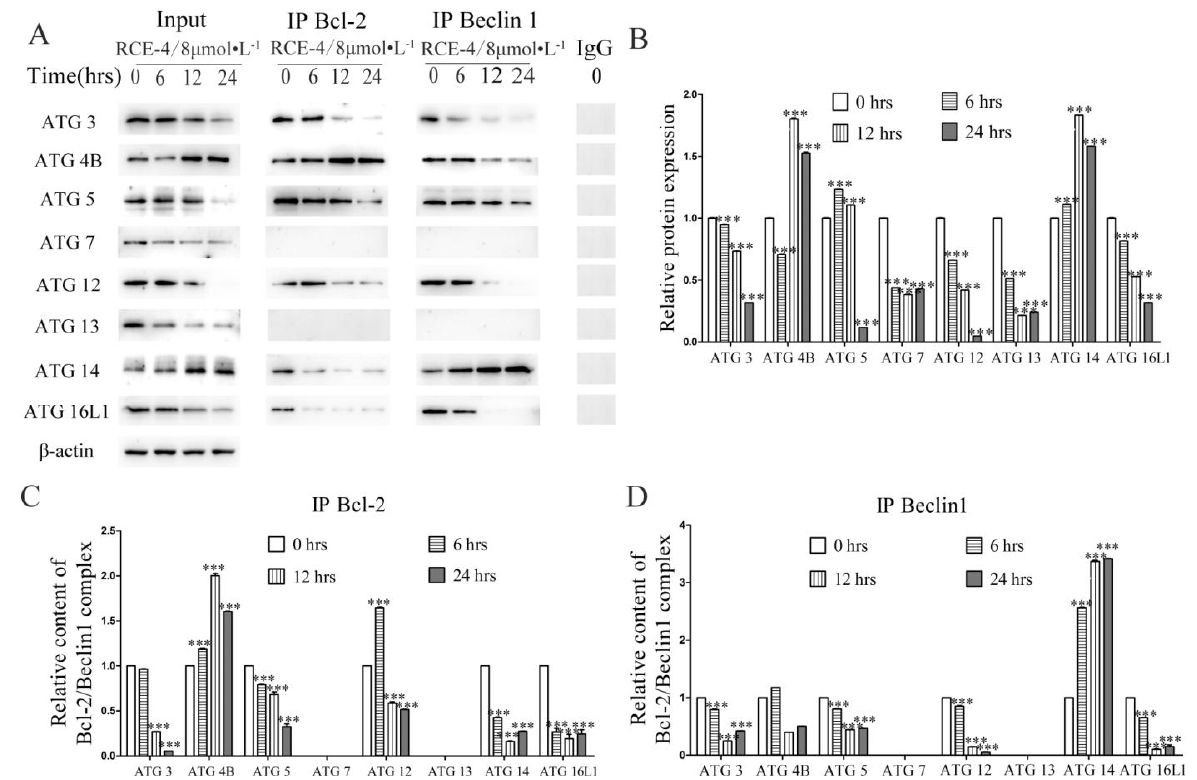
Figure 6. Analysis of the roles of ATG family proteins in the inhibition of Bcl-2–Beclin 1 complex induced by RCE-4. ( A ) The Ca Ski cells were treated with RCE-4 of 8 μmol/L for 6, 12, and 24 h. Following, the Co-IP experiments were performed. ( B – D ) Densitometry analysis of the expression of proteins. Data are presented as the mean ± standard deviation of three independent experiments. *** p < 0.001 vs. Control.